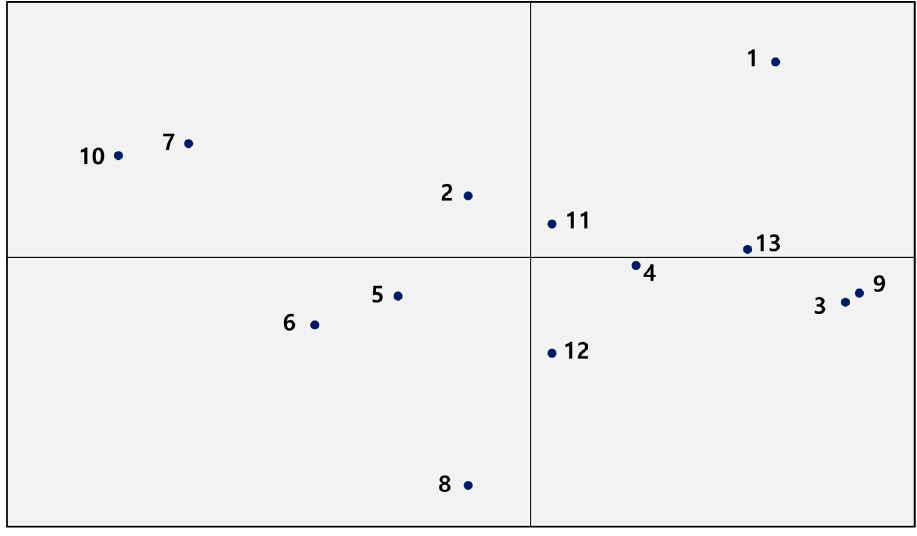
Figure 1. Modified IPA matrix of distribution strategy for the OTT streaming of dance.